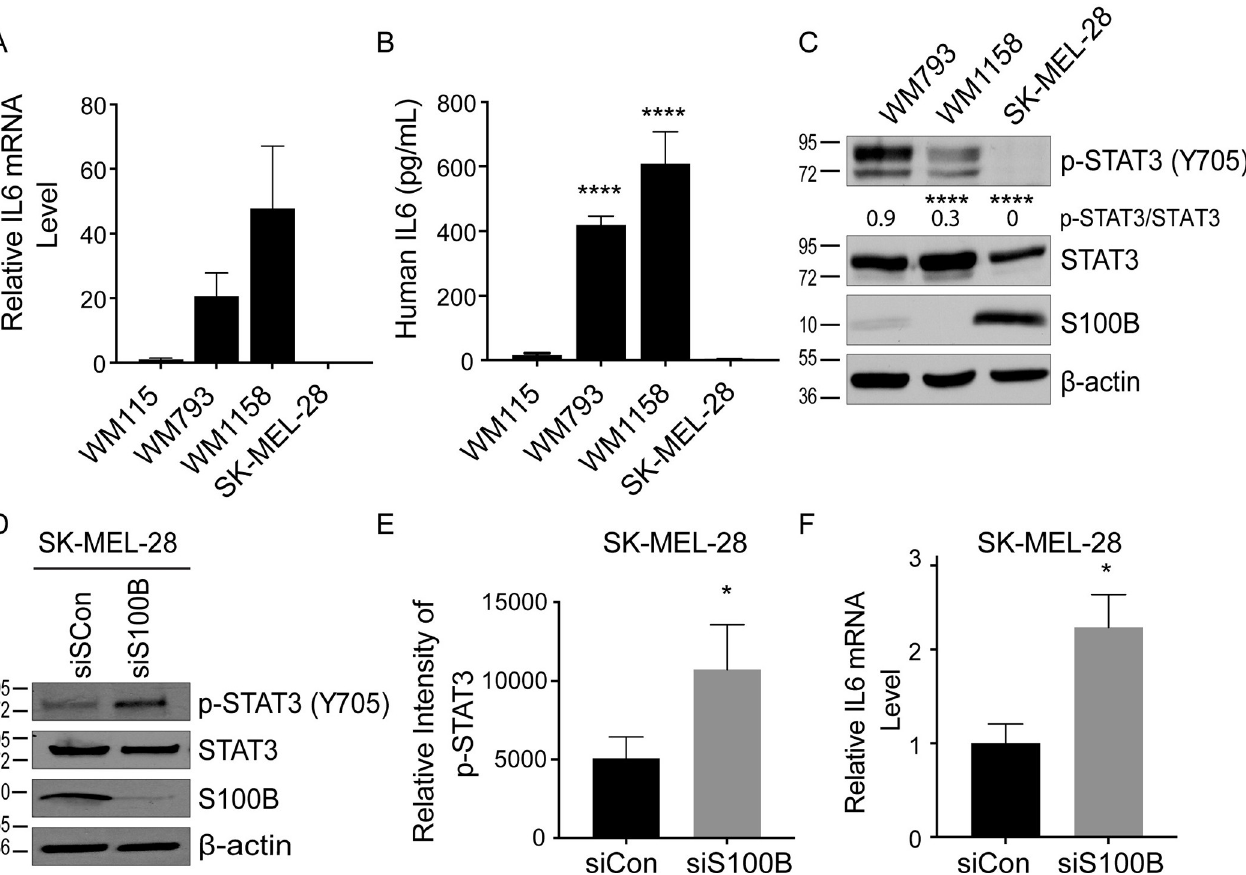
Fig 2. S100B levels changes IL6 and p-STAT3 in several melanoma cell lines. qRT-PCR used to measure the IL6 mRNA level (A) and an ELISA used to measure secreted IL6 protein level (B) show that S100B levels inversely correlate with IL6 mRNA and secreted protein levels in WM115, WM793, WM1158, and SK-MEL-28 cells (n = 3; mean ± SD; ���� , P < 0.0001). (C) Immunoblot analysis of p-STAT3 (Tyr705), total STAT3, and S100B in WM793, WM1158, and SK-MEL-28 melanoma cells showing that varying levels of S100B inversely correlate with p-STAT3 (Tyr705) levels (n = 3; mean ± SD; ���� , P < 0.0001). (D) Immunoblot analysis of p-STAT3, total STAT3, and S100B in SK-MEL-28 cells upon S100B knockdown using transient siRNA showed significant increases in p-STAT3 versus the control siRNA as represented graphically (E) (n = 3, mean ± SD; � , P < 0.05). (F) qRT-PCR shows IL6 mRNA in SK-MEL-28 cells transiently transfected with S100B targeting siRNA is significantly increased versus transfections with control siRNA (n = 3; mean ± SD; � , P < 0.05).